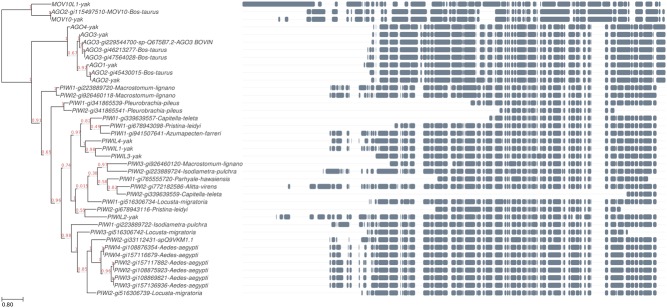
The neighbor-joining (NJ) tree of piRNA. NJ tree was built using the sequences of cattle, yak and other species and a bootstrap method. The value indicates the proportion of tree where a greater value indicates more reliable information with a maximum value of one, and a minimum value of zero. Bar = 80% nucleotide sequence divergence.